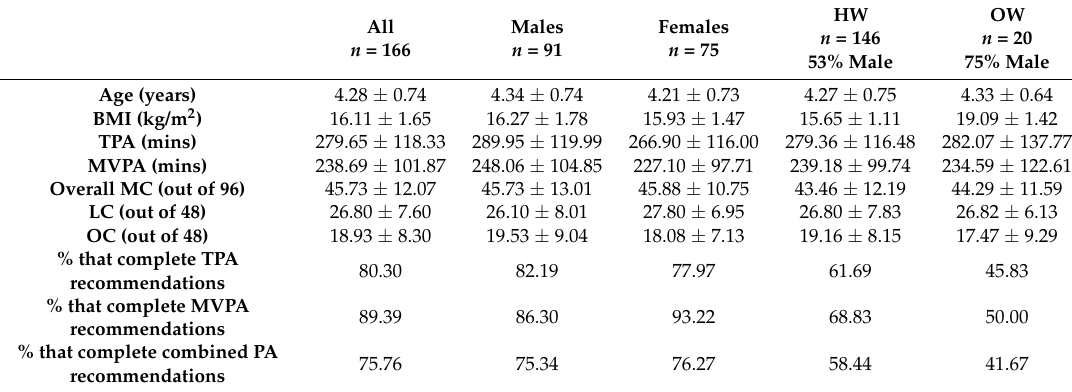
Table 1. Descriptive values of BMI, Physical Activity, and Motor Competence.